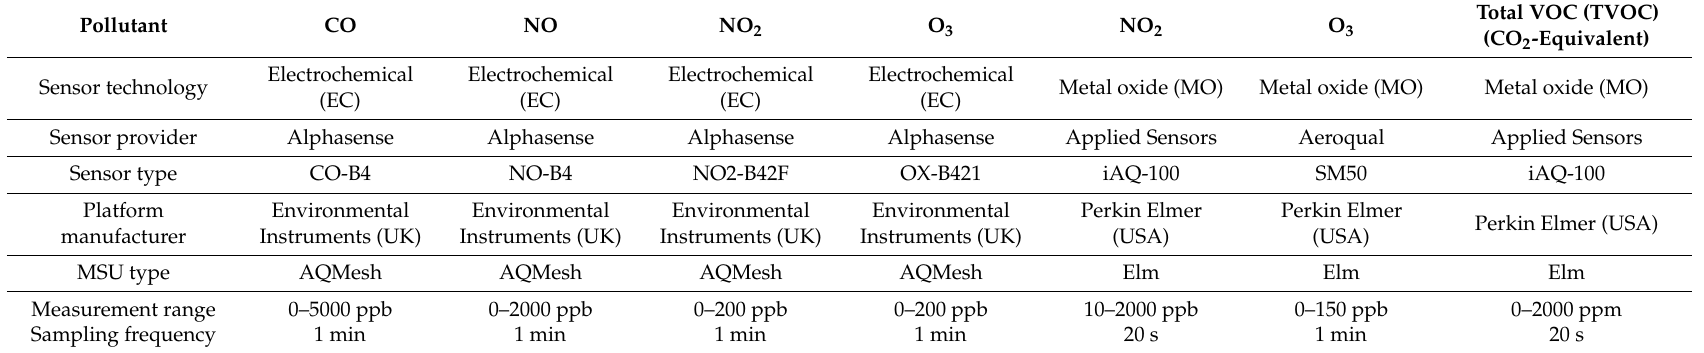
Table 1. Specifications of the stationary Monitoring Sensor Units (MSUs) for gaseous pollutant measurement.